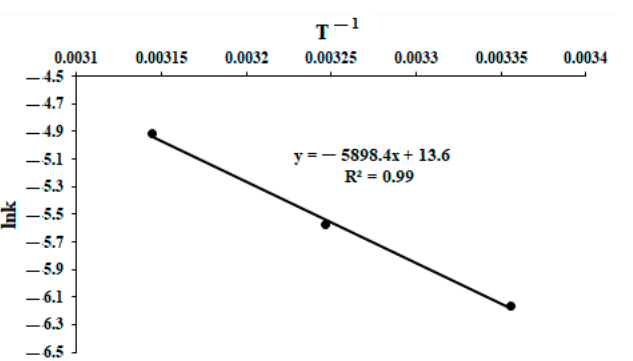
Figure 3. Temperature dependence of the rate constant of the oxidative polymerization of methylene blue in coordinates “lnk vs. T − 1 ”.